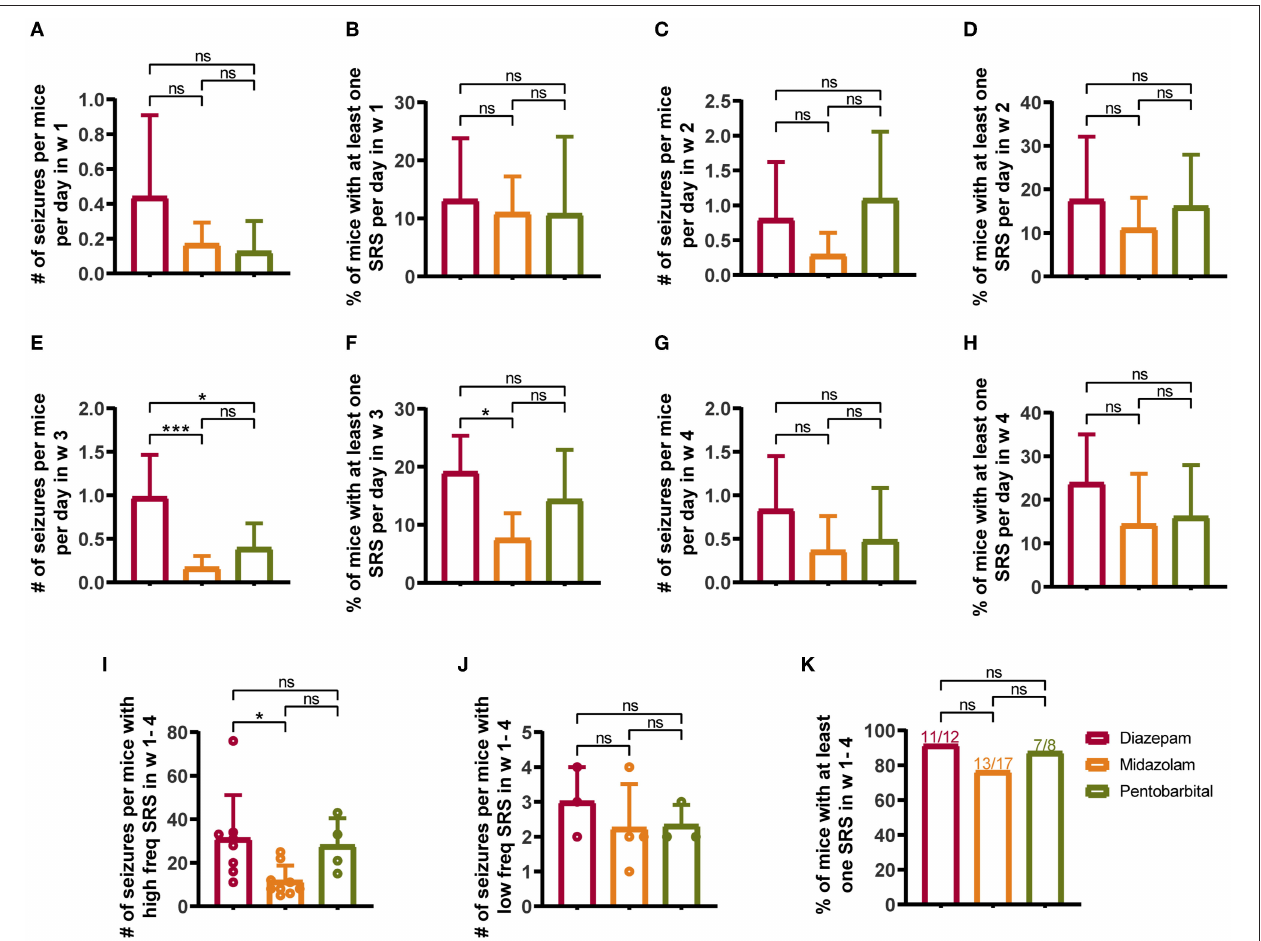
FIGURE 2 | Comparison of spontaneous recurrent seizures (SRSs) monitored for 4 weeks (W 1–4) from 7th to 35th days after SE treated with diazepam, midazolam, and pentobarbital. (A) Number of seizures per mouse per day in week 1 of different treatment groups. (B) Percentage of mice with at least one SRS per day in week 1 of different treatment groups. (C) Number of seizures per mouse per day in week 2. (D) Percentage of mice with at least one SRS per day in week 2. (E) A number of seizures per mouse per day in week 3. (F) Percentage of mice with at least one SRS per day in week 3. (G) Number of seizures per mouse per day in week 4. (H) Percentage of mice with at least one SRS per day in week 4. (I) A number of seizures per mouse with high-frequency SRS which was defined that the total number of seizures of a mouse was more than 4 in a week. (J) Number of seizures per mouse with low-frequency SRS, which was defined that the total number of seizures of a mouse was 4 or less per week. (K) Percentage of mice with at least one SRS in weeks 1–4. (A–J) One-way ANOVA with post-hoc Tukey’s multiple comparisons test. (K) Fisher’s exact test, * p < 0.05, *** p < 0.001, ns indicates no significant difference. Data were presented as mean ± SD. See also Supplementary Table 1